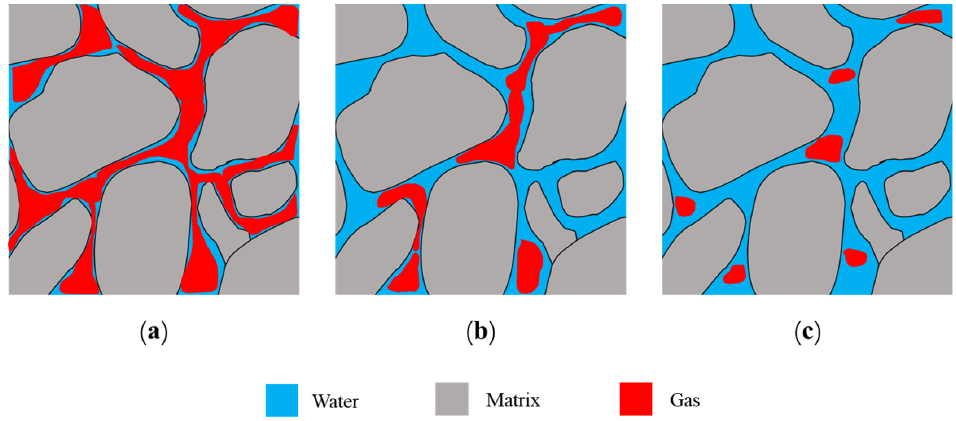
Figure 7. Schematic of gas and water microscopic distribution in tight gas reservoirs: ( a ) gas flows in the dominant channel; ( b ) gas forms discontinuous phase; ( c ) gas is divided into small bubbles.